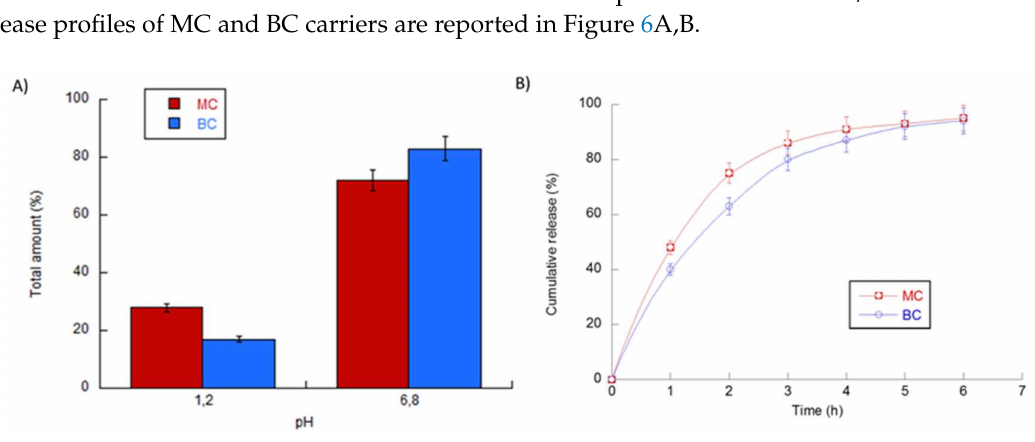
Figure 6. Release properties of BC and MC micro-vectors. ( A ) KL total amount (%). All samples were conditioned into simulated gastric fluids (SGF) (pH 1.2) for the first 2 h, and simulated intestinal fluids (SIF) (pH 6.8) for the next 6 h, until the end of release. ( B ) Cumulative release in SIF (%). All tests were conducted in triplicate for each time, for both sample